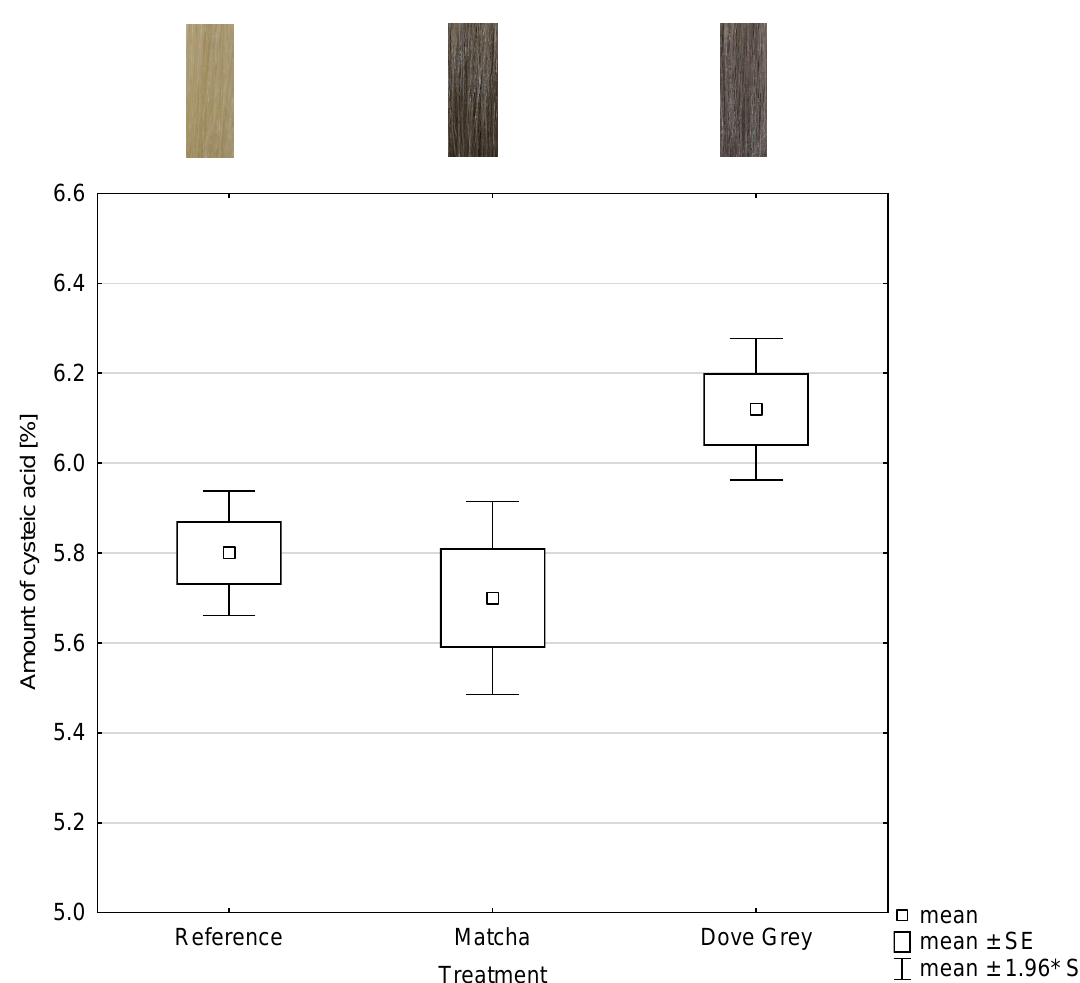
Figure 4. First derivation FT-NIR-spectra of hair tresses after 3 times bleaching and dyed with Dove Grey with n = 5.